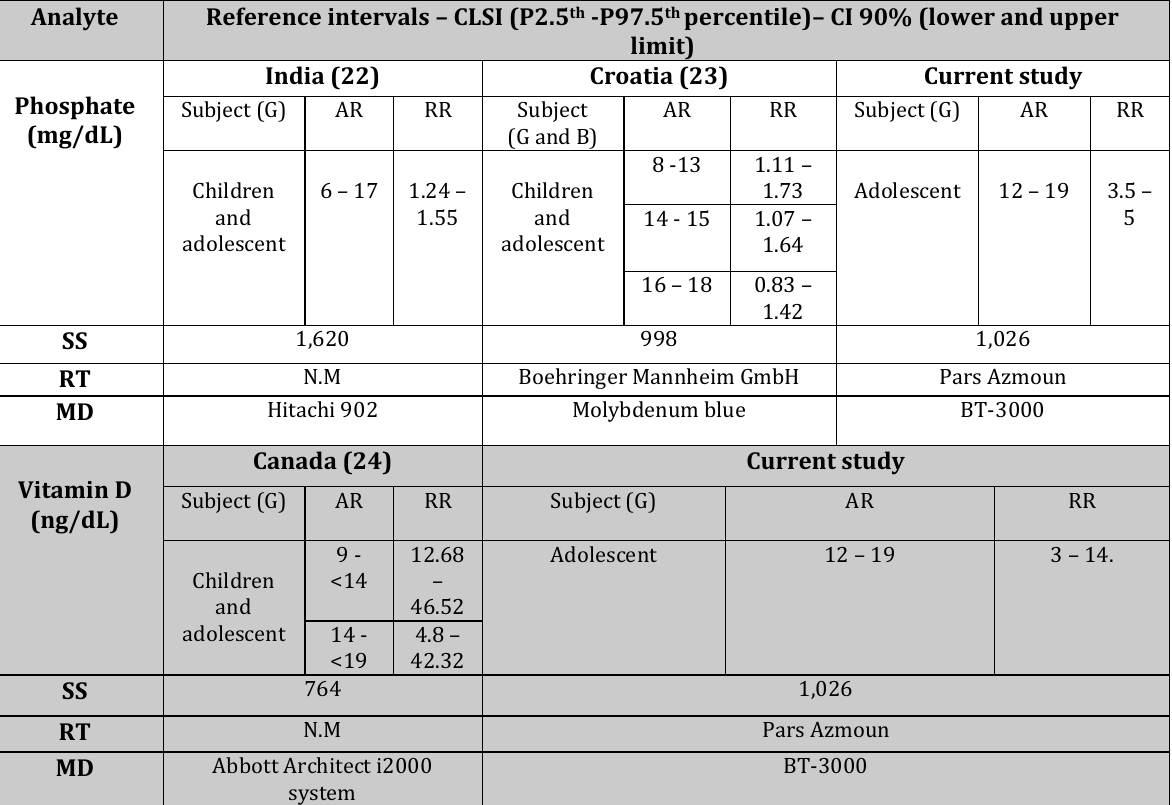
Continue Table 2 . Comparison of reference intervals of the current study population with reference intervals of other